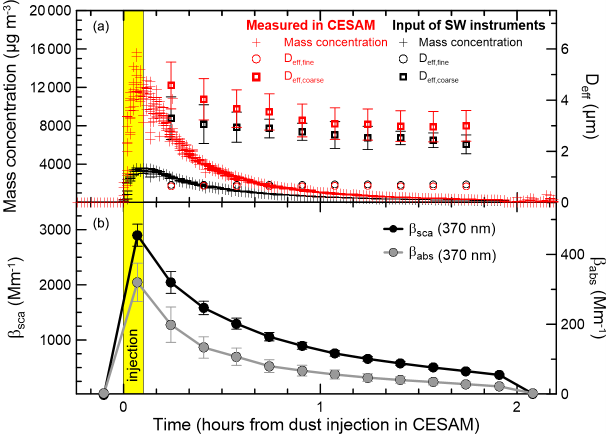
Figure 3. (a) Time series of the aerosol mass concentration (cross symbols) and effective fine ( D eff , fine , open dots) and coarse diame- ter ( D eff , coarse , open squares) measured inside the CESAM cham- ber (red symbols) and at the input of the SW instruments (black symbols) for one experiment (Morocco dust). (b) Time series of the scattering β sca and absorption β abs coefficients at 370nm for the same experiment. Mass concentrations are reported as 6s data, while all other quantities are 10min